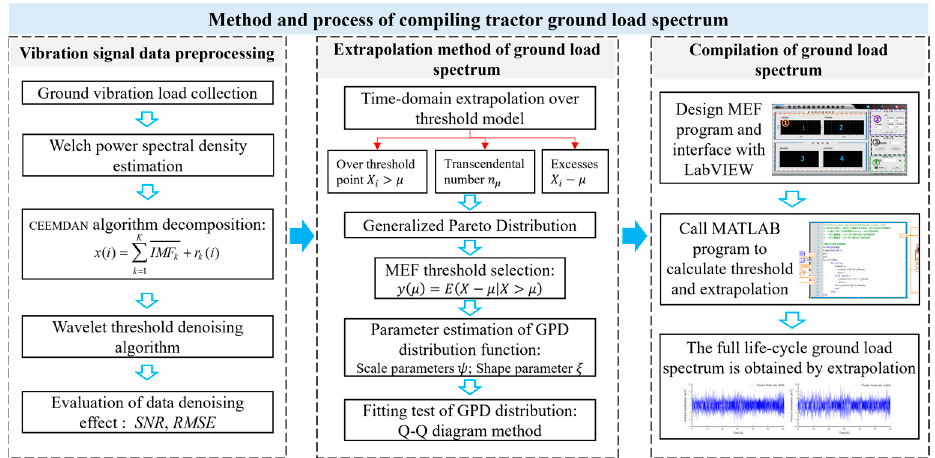
Figure 5. Research on compiling method of tractor ground load spectrum.